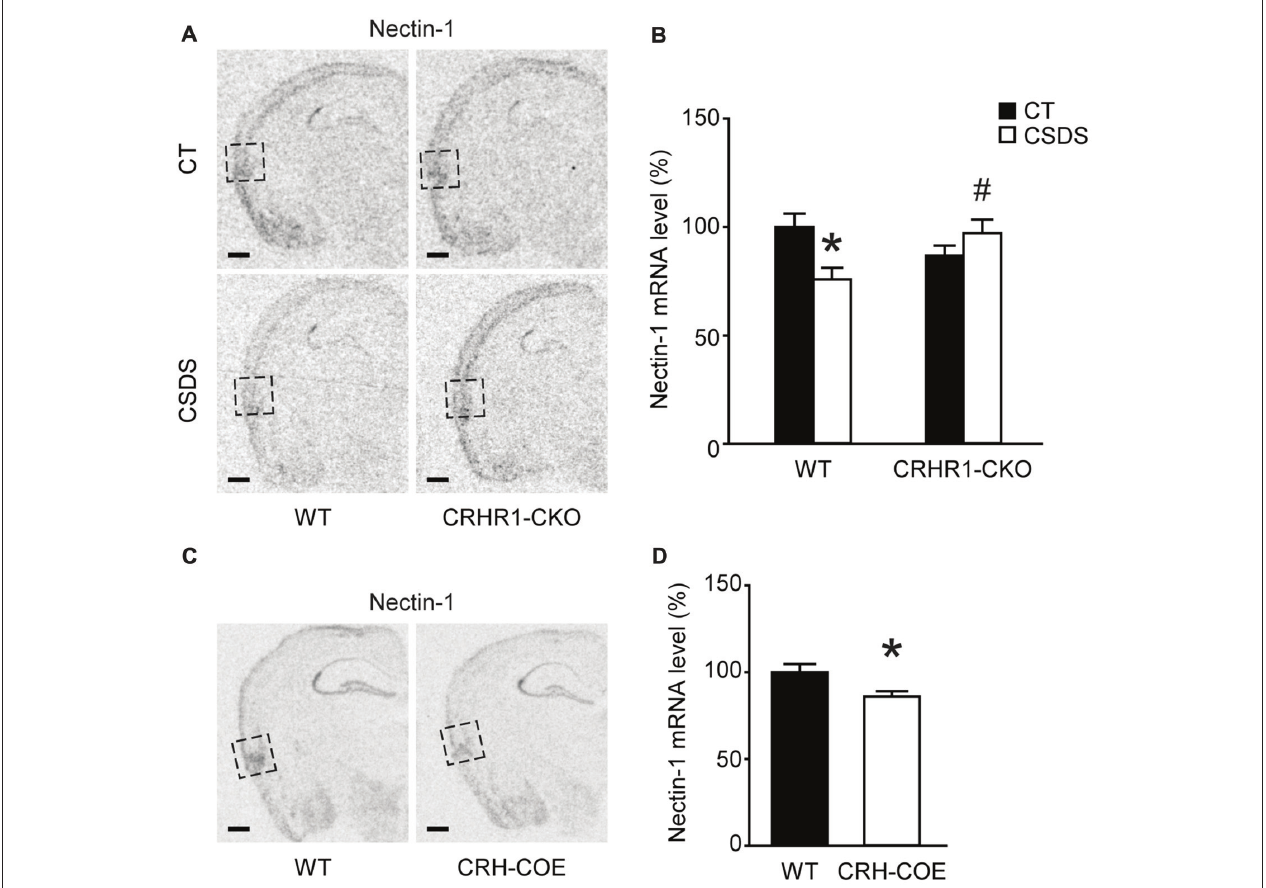
FIGURE 3 | Effects of CSDS and the CRH-CRHR1 system on nectin-1 mRNA levels in the perirhinal cortex. (A) Representative in situ hybridization images showing nectin-1 mRNA expression in the perirhinal cortex (boxed regions) of WT or CRHR1-CKO mice with or without chronic stress exposure. (B) Nectin-1 mRNA levels in the perirhinal cortex were reduced by chronic stress in WT but not CRHR1-CKO mice. n = 6–8 mice per group. (C) Representative in situ hybridization images showing nectin-1 mRNA expression in the perirhinal cortex (boxed regions) of WT or CRH-COE mice. (D) Perirhinal nectin-1 mRNA levels were reduced in CRH-COE mice. n = 9 mice per group. All scale bars = 500 µ m. ∗ p < 0.05 vs. the control WT group; # p < 0.05 vs. the stressed WT group.